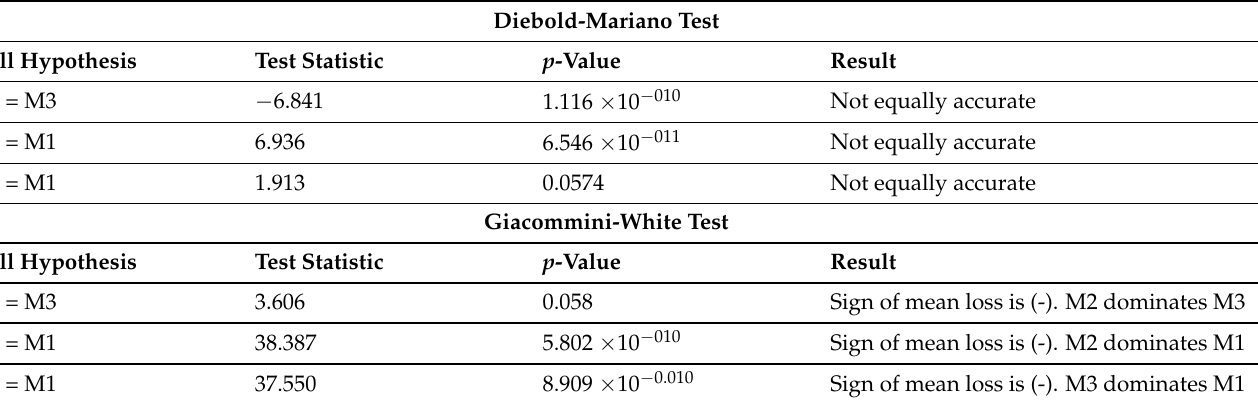
Table 6. Model comparisons (M1(Linear), M2(GP), M3(GP-AR)) using validation set CSIR, UNZ, and